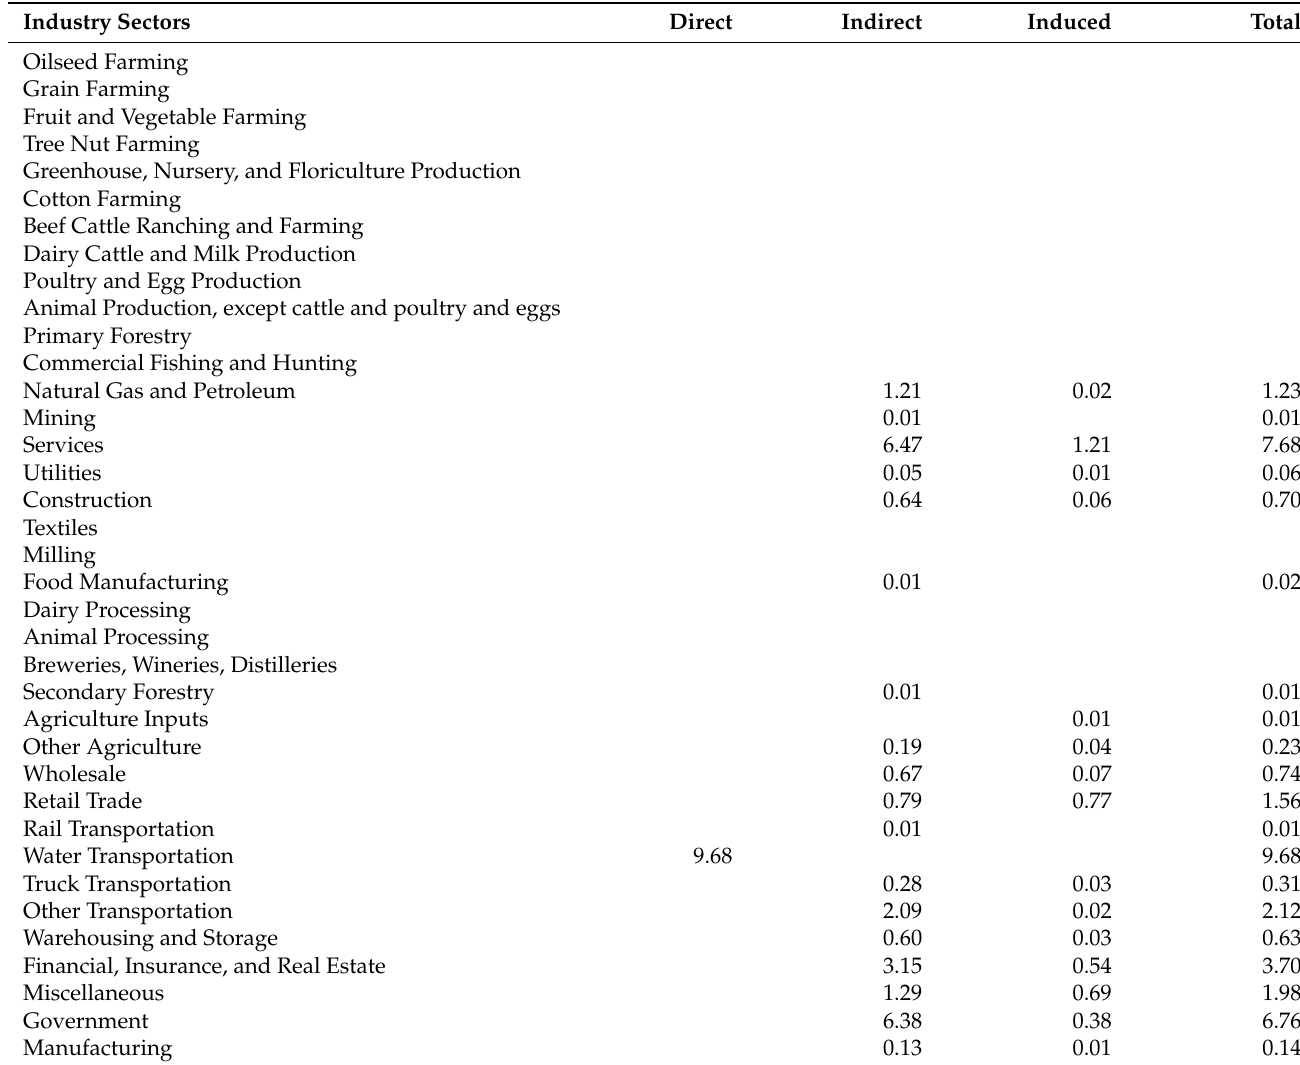
Table 5. Contribution of the water transportation to employment by industry (number of jobs).